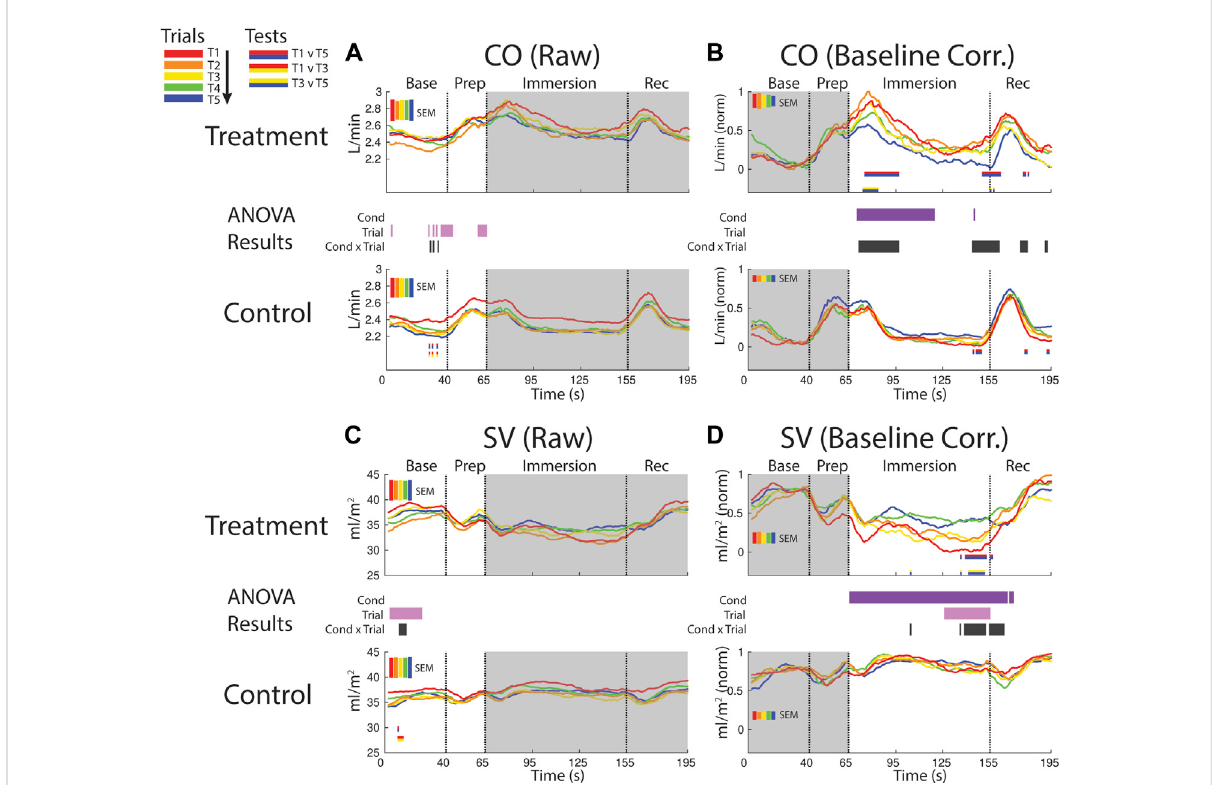
FIGURE 6 Effects of treatment and repeated trial exposure on cardiac output [CO; (A , B)] and stroke volume [SV; (C , D)] . Pre-exposure and evoked stress effectsarere fl ectedinraw(leftcolumn)andbaselinecorrected/normalized(rightcolumn)plots,respectively.Eachpanelcontainsaseparateplotfor thetreatmentandcontrolcondition,withthemeanresponseacrossparticipantsineachrepetitiontrial(T1-T5)representedineachplotbyadifferent color (ROYGB). Horizontal lines positioned between treatment and control plots indicate statistically signi fi cant ANOVA main effects of condition (dark purple), trial (light purple) and the condition x trial interaction (dark gray) at designated timepoints ( p null < 0.05). Horizontal red/blue, red/yellow and yellow/blue lines at the base of treatment and control plots respectively indicate statistically signi fi cant pairwise comparison results forT1vT5,T1vT3andT3vT5atthedesignatedtimepoints( p null < 0.05).Post-immersionrawdataandpre-immersionbaselinecorrectednormalized data are greyed out as these periods are not relevant to the pre-exposure/evoked stress analyses. The set of fi ve vertical error bars labelled SEM on each plot represent ±SEM of the data averaged over the time-course of